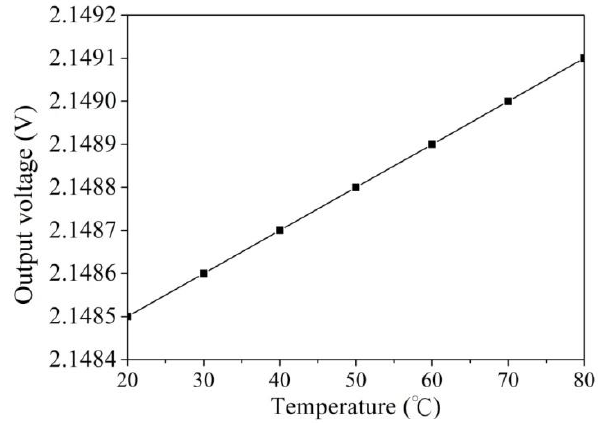
Figure 3. Relation between output voltage and temperature for the